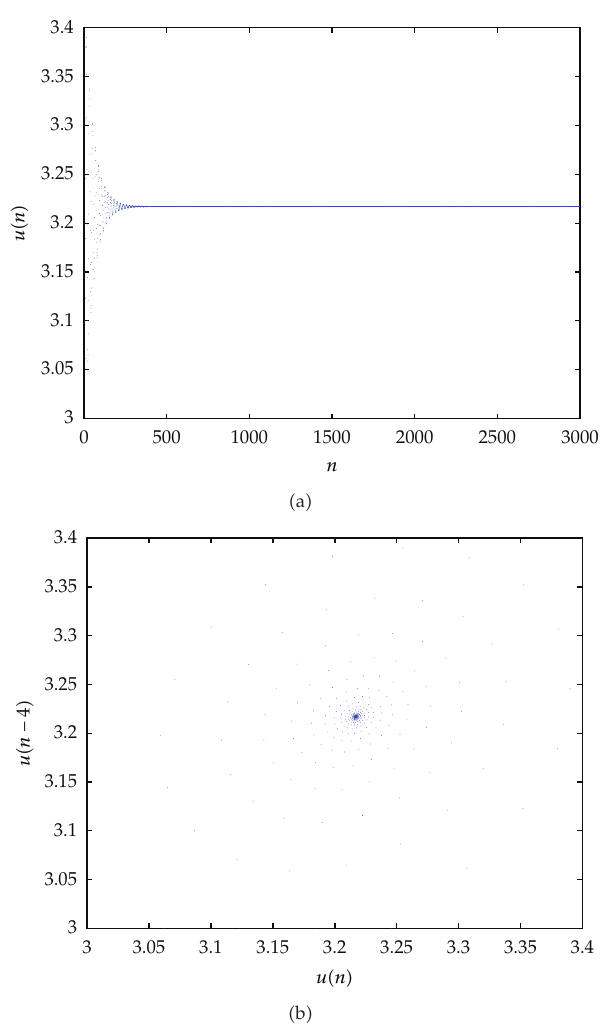
Figure 1: (cid:2) a (cid:3) The equilibrium u ∗ of (cid:2) 2.2 (cid:3) is asymptotically stable for τ (cid:7) 0 . 9 < τ 0 (cid:7) 1 . 0159, (cid:2) b (cid:3) Phase plot of (cid:2) 2.2 (cid:3) on the plane (cid:2) u (cid:2) n (cid:3) ,u (cid:2) n − 4 (cid:3)(cid:3) for τ (cid:7) 0 . 9 < τ